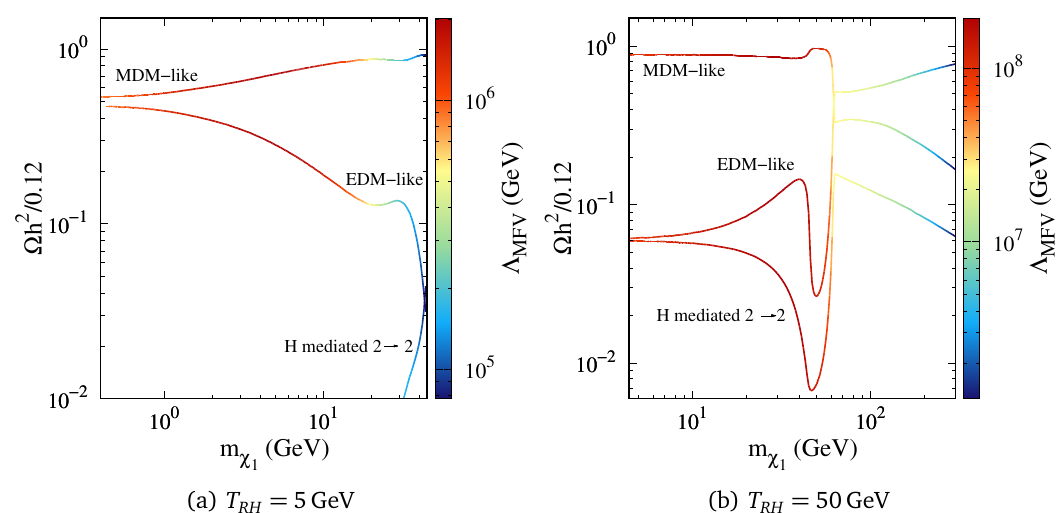
Figure 2: Fractional contribution of different annihilation channels to the total relic density, with Λ (shown in color) chosen to reproduce the observed relic density MFV for each DM mass.